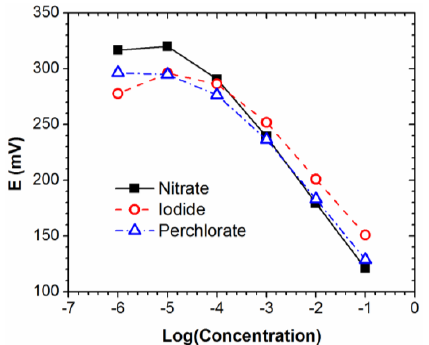
Figure 3. Response of a conductive polymer film ISE for nitrate that was undoped after film growth. Response to nitrate and interferent anions iodide and perchlorate shows little selectivity for nitrate against the